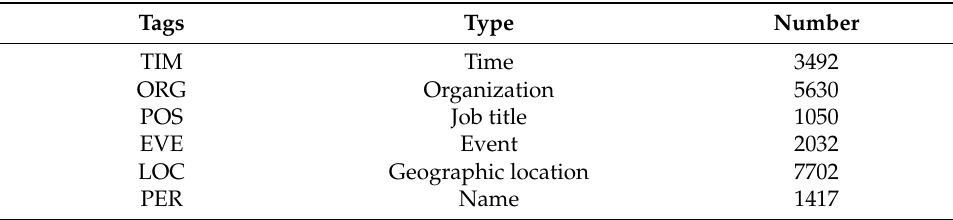
Table 1. The number of various entities in the annotated corpus.